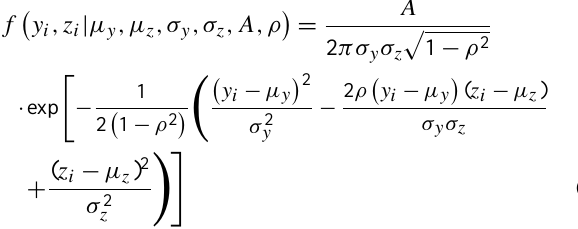
find the best fit between a template function and the wind speed distribution, and the approach applied by Aitken et